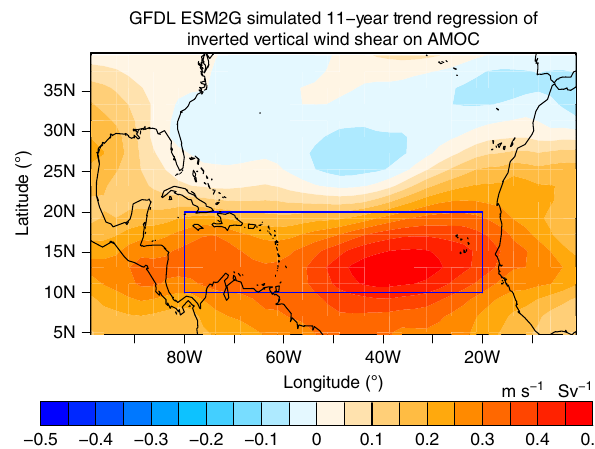
Fig. 5 Modeled trend regression from the GFDL-ESM2G control simulation. The 11-year trends of inverted vertical shear of zonal wind are regressed on the 11-year trends of the AMOC Index at 26°N. Blue box: Atlantic hurricane main development region (MDR: 80°W – 20°W, 10°N – 20°N). The results are based on all available 11-year segments sampled from the control simulation. Positive values imply an increase in vertical wind shear when AMOC declines, and vice